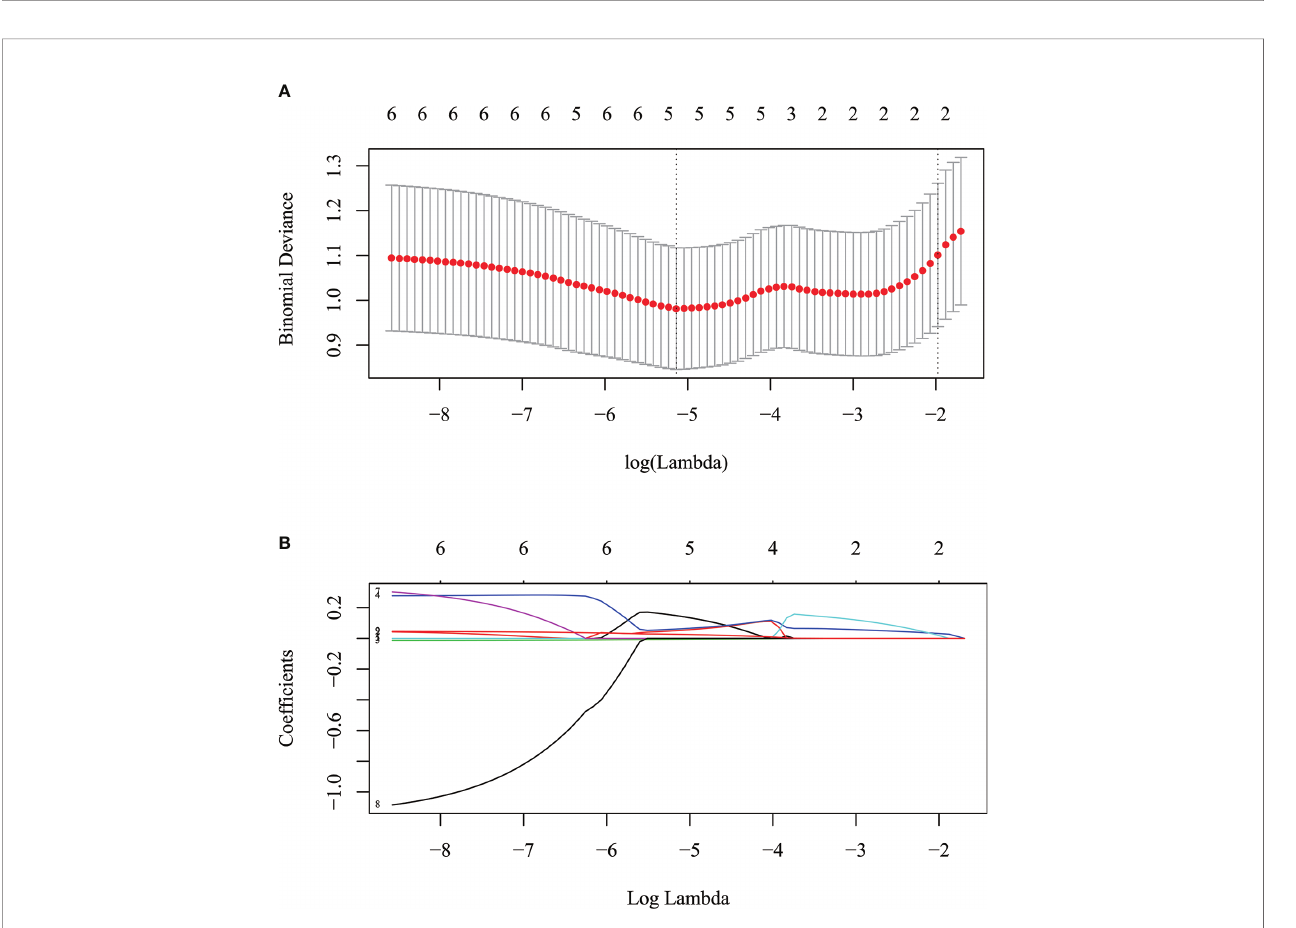
FIGURE 6 | The selection of optimal MPs using the LASSO algorithm. (A) The optimal tuning parameter (Lambda) in the LASSO model was selected using 10-fold cross-validation at the minimum of lambda. (B) LASSO coef fi cient pro fi les of the 9 parameters. According to the 10-fold cross-validation in (A) , Five parameters with non-zero coef fi cients were included for metabolic signature